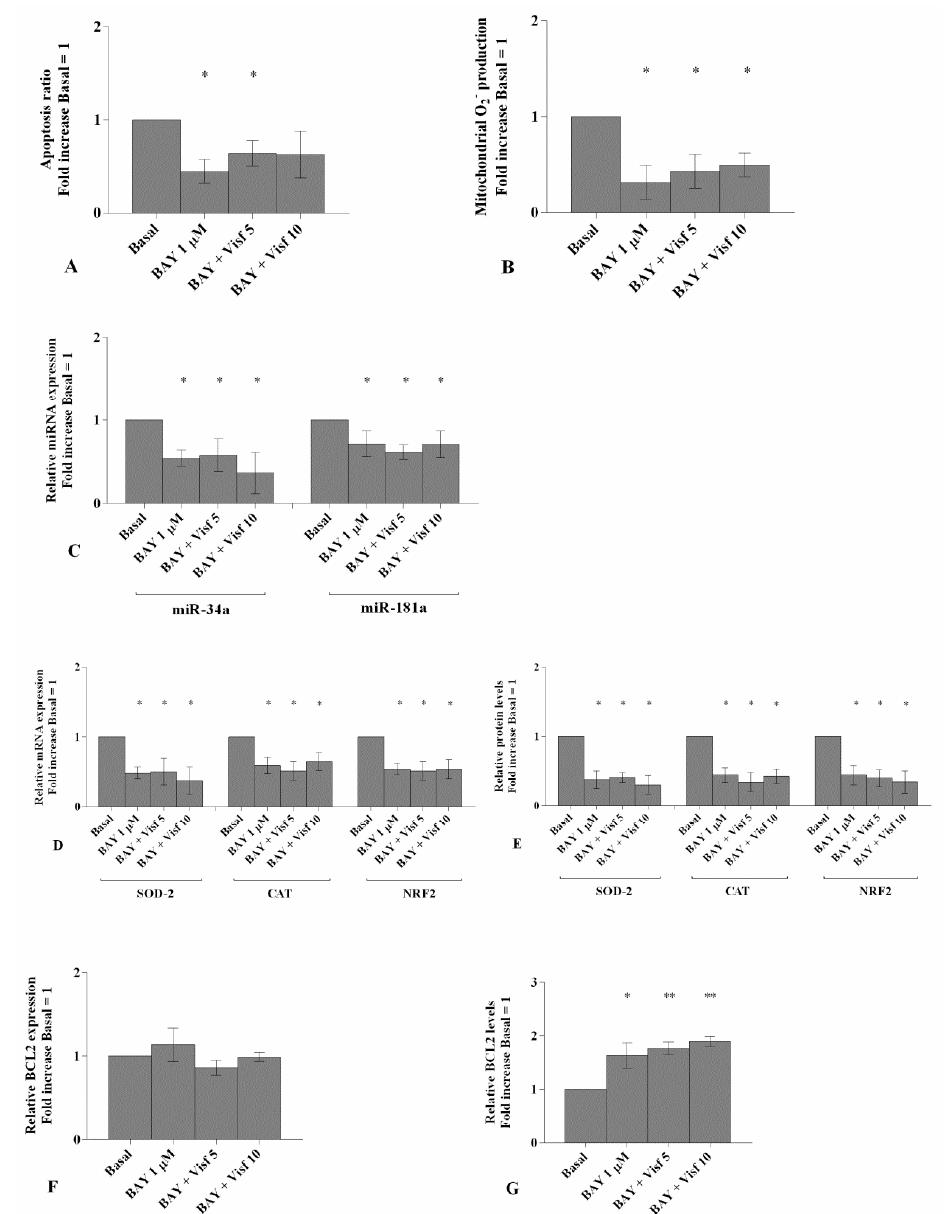
Figure 5. ( A ) Detection of apoptosis by flow cytometry analysis. Apoptosis was measured with Annexin Alexa fluor 488 assay. Data were expressed as percentage of positive cells for Annexin-V and propidium iodide (PI) in all the studied conditions. ( B ) The production levels of mitochondrial superoxide anion by flow cytometry analysis using MitoSox Red staining. Expression levels of miR-34a, miR-181a ( C ), superoxide dismutase (SOD-2), catalase (CAT), nuclear factor erythroid 2 like 2 (NRF2) ( D ) and B-cell lymphoma (BCL2) ( F ) by real-time PCR. ( E , G ) Densitometric analysis of SOD-2, CAT, NRF2 and BCL2 protein levels by western blot. Human osteoarthritic (OA) chondrocytes were evaluated at basal condition, after 2 h pre-incubation with a specific nuclear factor (NF)- κ B inhibitor (BAY 11-7082, IKK α / β , 1 µ M) and after 24 h of stimulus with visfatin (5 µ g / mL and 10 µ g / mL). The ratio of apoptosis, the production of superoxide anion, the gene expression and the protein levels were referenced to the ratio of the value of interest and basal condition (Basal, cells without treatment). The value of basal condition was reported equal to 1. Data were expressed as mean ± SD of triplicate values. * p < 0.05, ** p < 0.01 versus basal condition. BAY = BAY 11-7082, Visf =